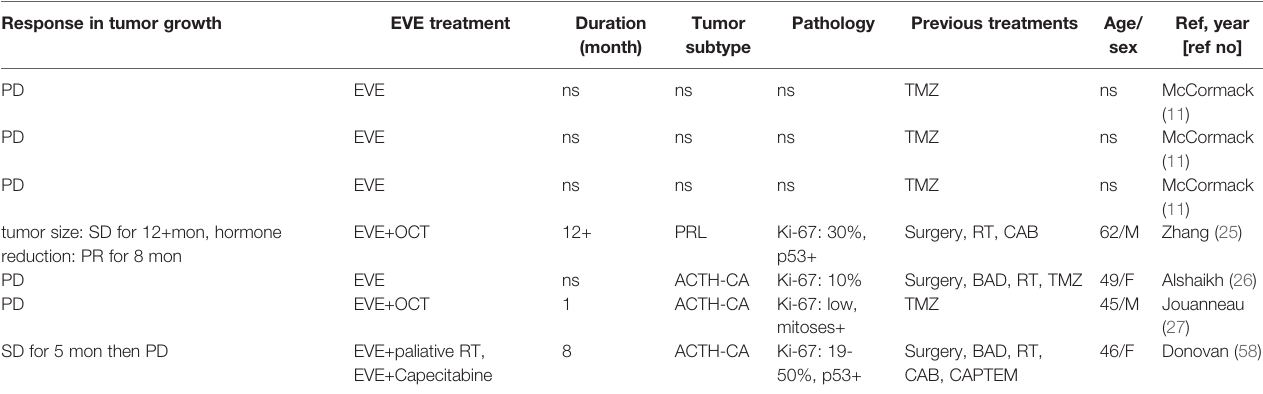
TABLE 4 | Published cases of Everolimus (EVE) treatments for pituitary tumors and